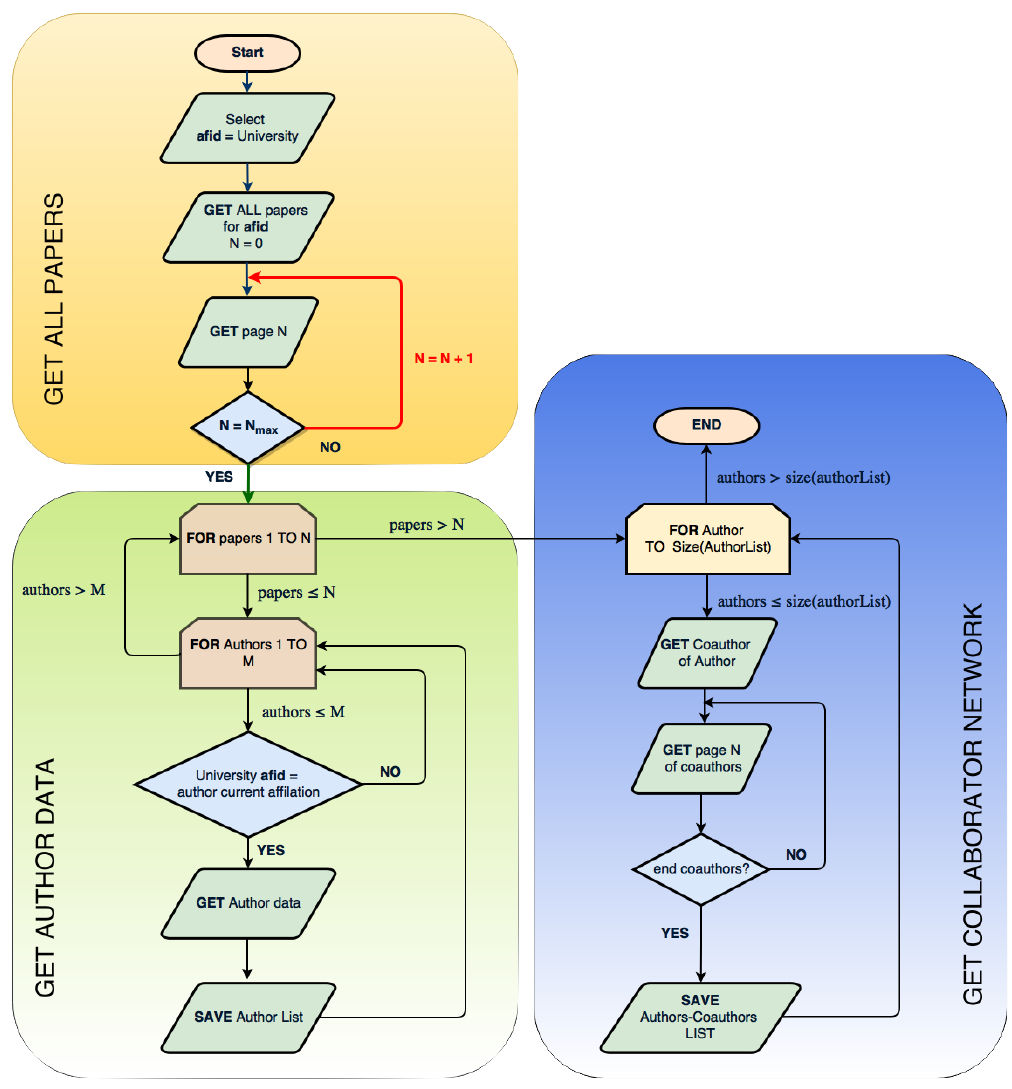
Figure 1. Flowchart for ResNetBot